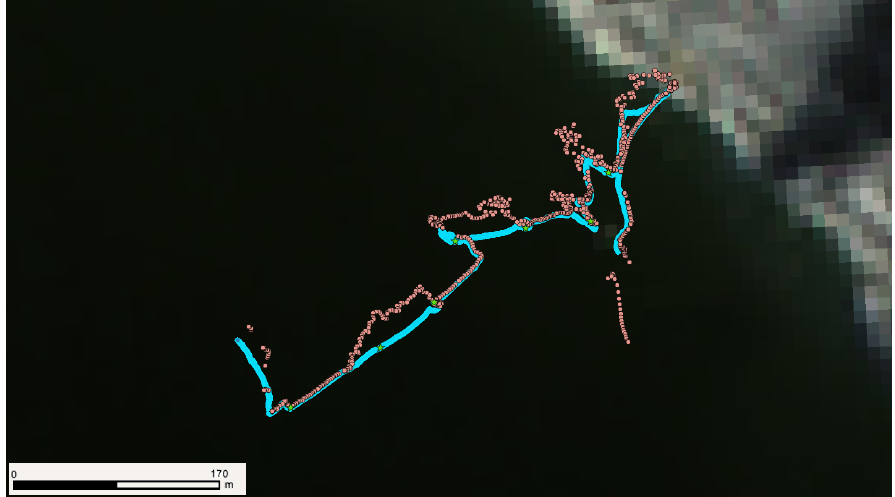
Figure 26. EXCELLABUST project: Path of PROTEUS USSV (cyan), aerostat multi-parametric gauge (pink), and water sampling points (green stars), while approaching the front of Blomstrandbreen